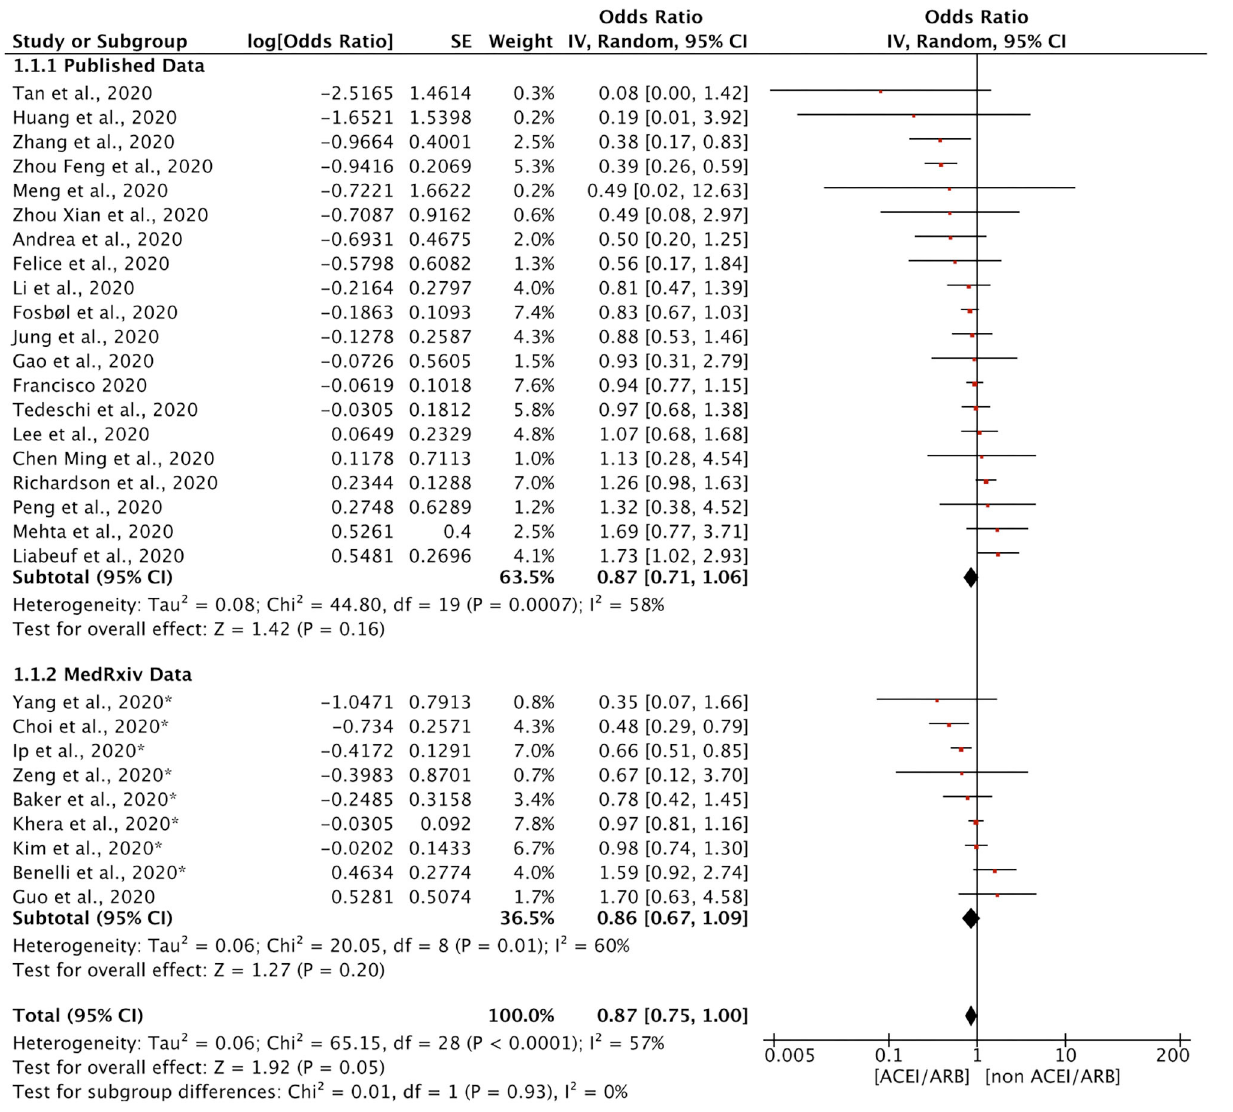
FIGURE 2 | Forest plot showing the effects of ACEIs/ARBs on all-cause mortality in patients with COVID-19. SE, standard error; IV, inverse variance; df, degrees of